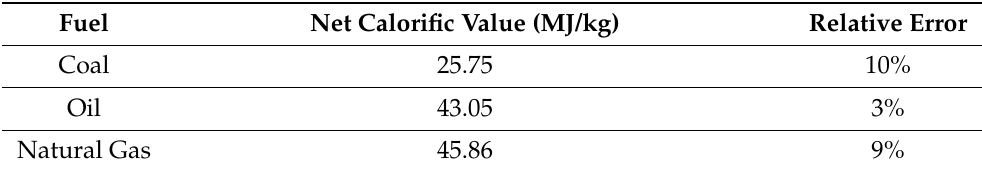
Table A2. In our data source, the unit of commodities is kilogram. Net calorific value was used for every type of fuel [47]. Net calorific value shows what amount of energy is contained in one kilogram of